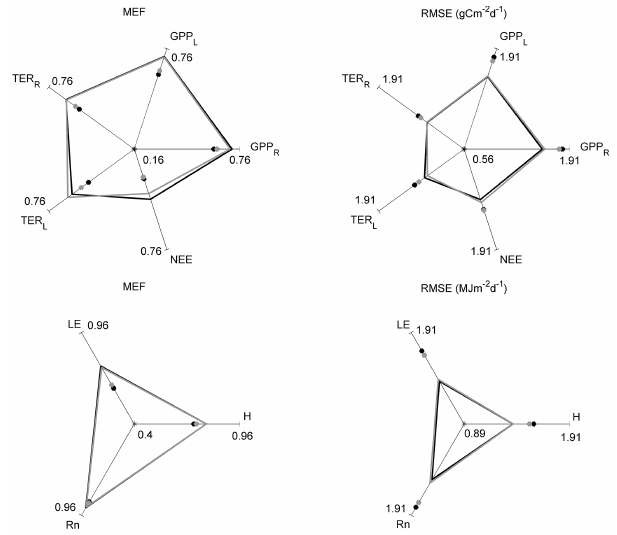
Figure 1. Spider plot of MEF (first column) and RMSE (second column) for CO 2 (first row) and energy fluxes (second row) show- ing the consistency of prediction made by the RS (black line) and RS + METEO (grey lines) setups. The lines were the ensemble me- dian estimate of ML; we also showed the performance of multiple regressions trained with RS (black point) and RS + METEO (grey points). GPP R and GPP L were, respectively, the gross primary pro- duction estimated following Reichstein et al. (2005) and Lasslop et al. (2010), TER R and TER L the total ecosystem respiration esti- mated following Reichstein et al. (2005) and Lasslop et al. (2010), NEE net ecosystem exchange, H the sensible heat, LE the latent heat, and Rn the net